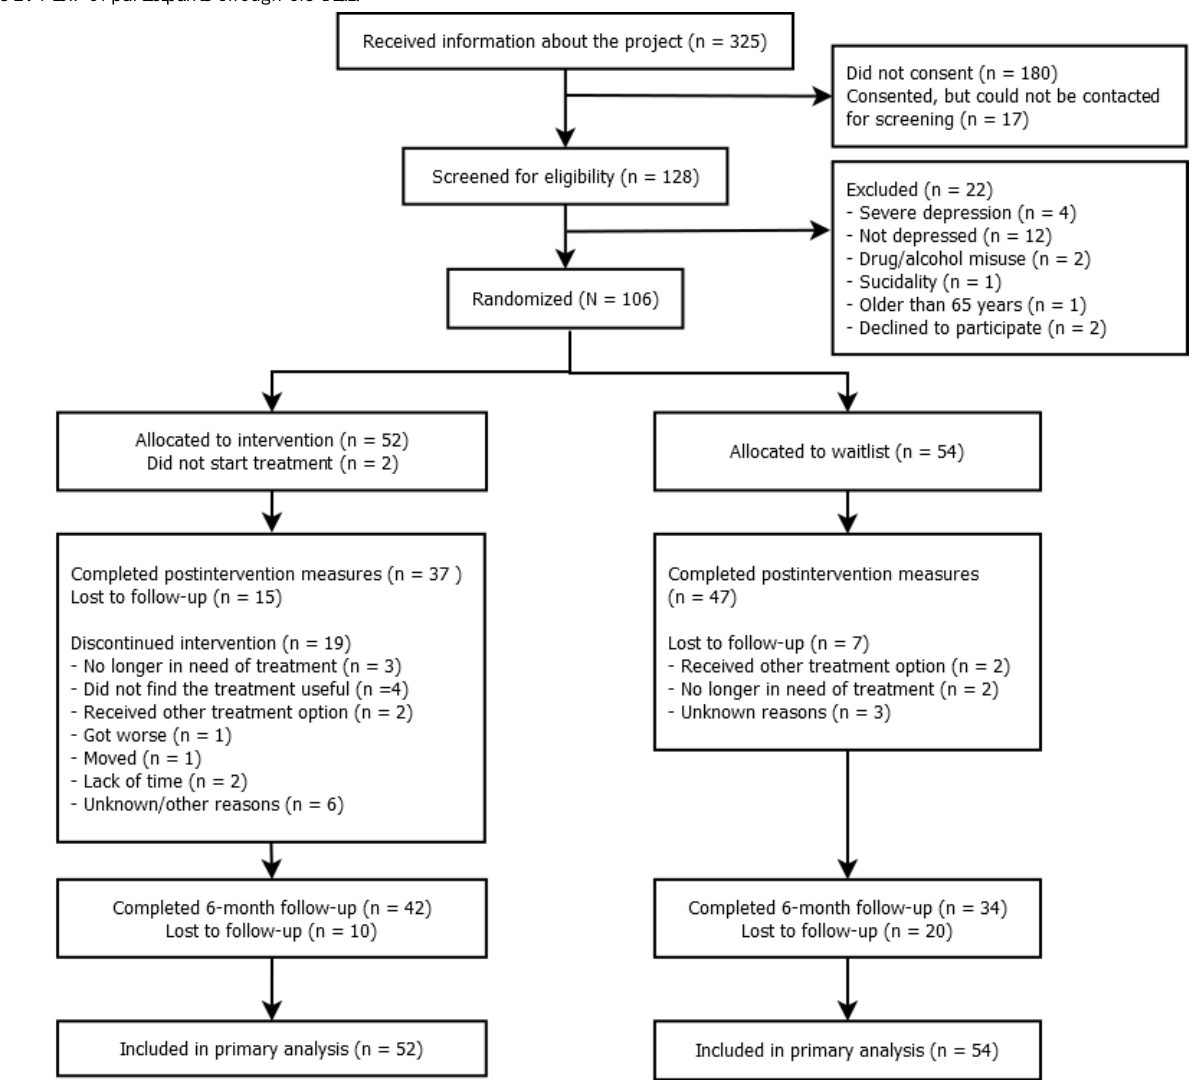
Figure 2. Flow of participants through the